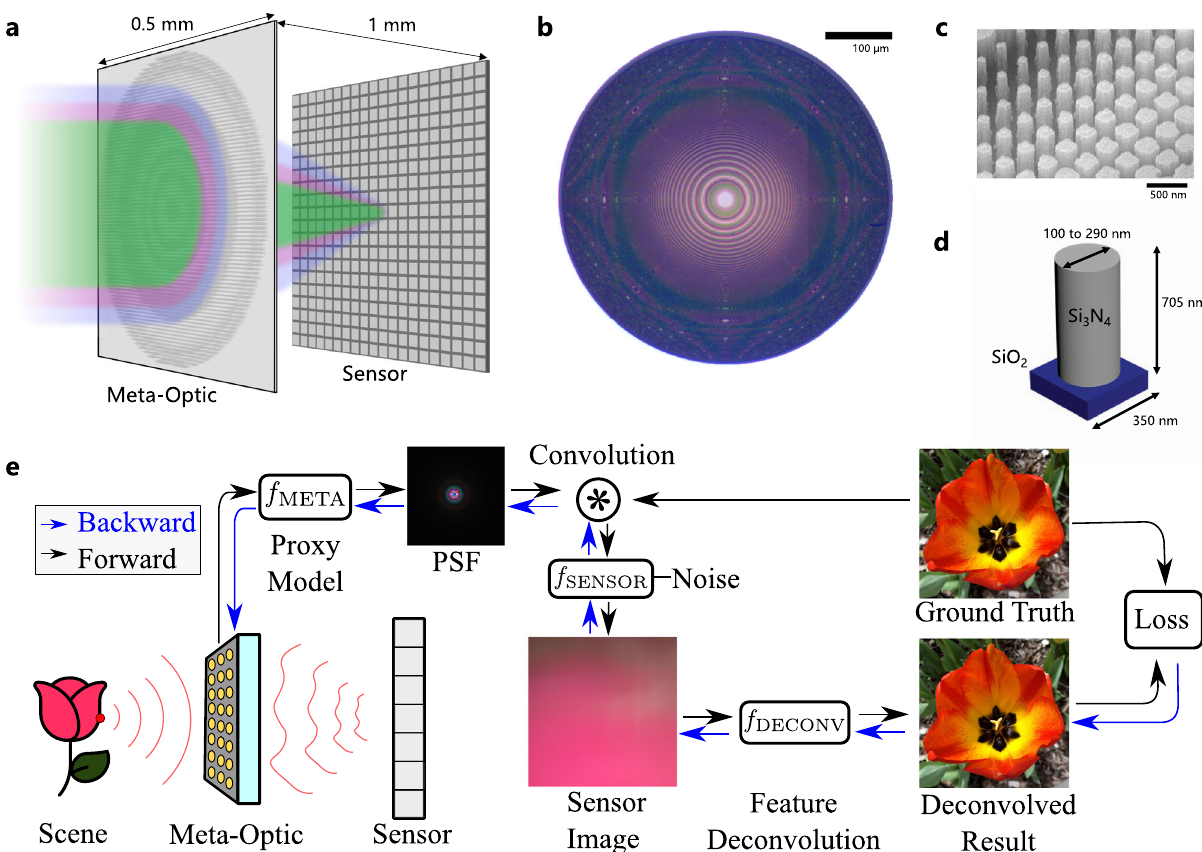
Fig. 1 Neural nano-optics end-to-end design. Our learned, ultrathin meta-optic as shown in ( a ) is 500 μ m in thickness and diameter, allowing for the design of a miniature camera. The manufactured optic is shown in ( b ). A zoom-in is shown in ( c ) and nanopost dimensions are shown in ( d ). Our end-to- end imaging pipeline shown in e is composed of the proposed ef fi cient metasurface image formation model and the feature-based deconvolution algorithm. From the optimizable phase pro fi le, our differentiable model produces spatially varying PSFs, which are then patch-wise convolved with the input image to form the sensor measurement. The sensor reading is then deconvolved using our algorithm to produce the fi nal image. The illustrations above “ Meta- Optic ” and “ Sensor ” in ( e ) were created by the authors using Adobe